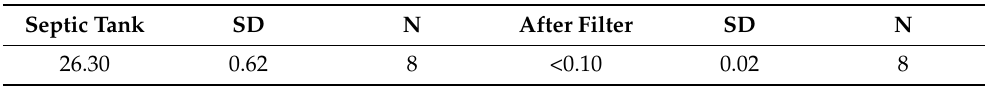
Table 4. Average concentration of surfactants (mg/L) with standard deviation (SD) in the waste water samples from the WWTP ECOkocka.